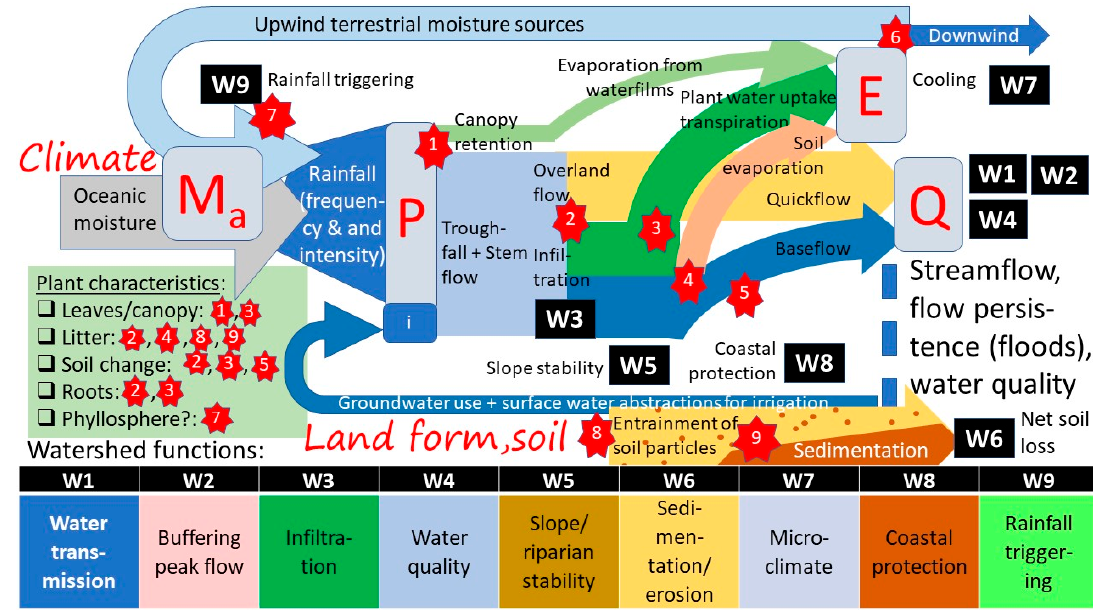
Figure 6. Ecosystem structure (landform, soil, plant characteristics), processes ( 1 – 9 ), and ‘watershed functions‘ ( W1 – W9 ) based on water balance: P = precipitation, Q = stream flow, E = evapotranspiration, M a = atmospheric moisture, i = irrigation.